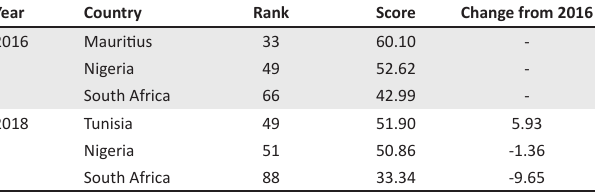
TABLE 3: Integrated Index for Postal Development ranking and scores for South Africa and the two top African countries. Year